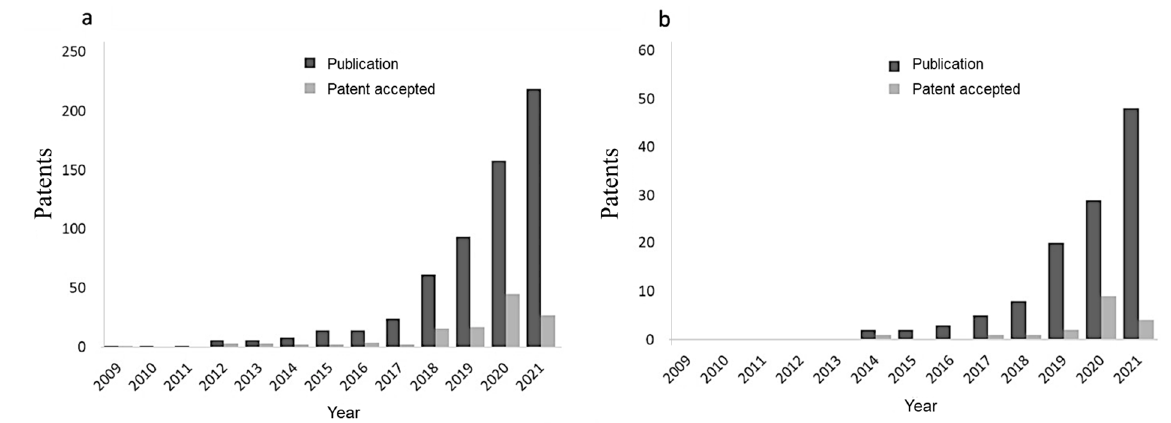
Figure 2. Number of patents applied for and published per year. ( a ): Patents corresponding to organoids. ( b ): Patents corresponding to organoids for cancer. The data were obtained through “Patent inspiration”, adding “Organoid”, “AND”, and “Cancer” as filters.